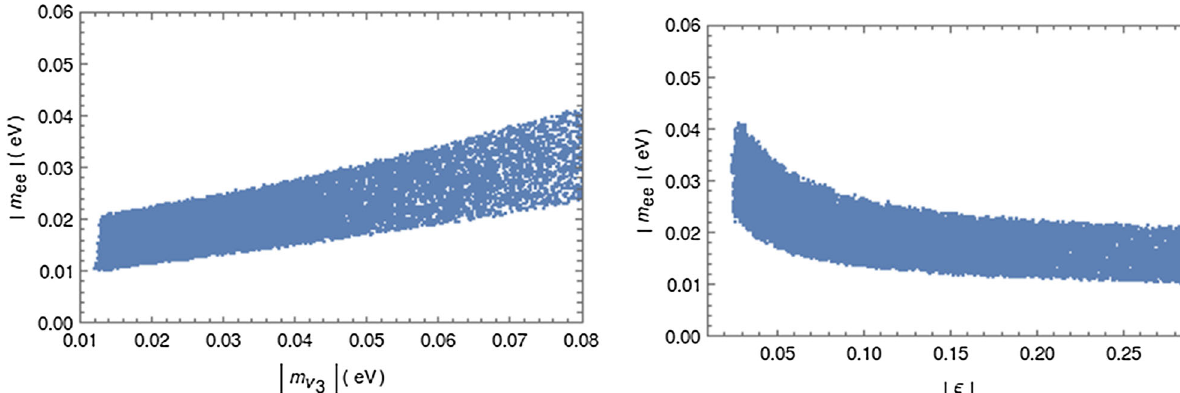
Fig. 5 | m ee | versus | m 0 ν